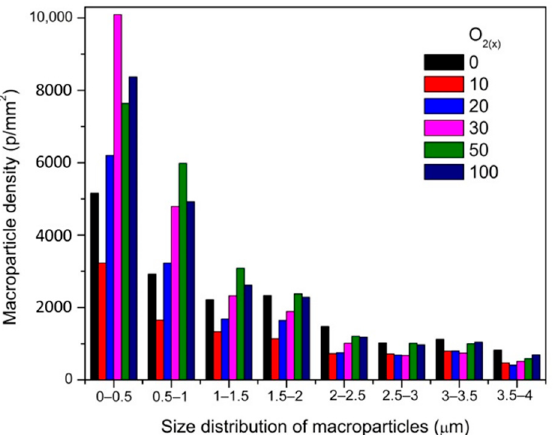
Figure 3. Size distribution and macroparticles density of ZrON coatings synthesized at various O 2(x) .